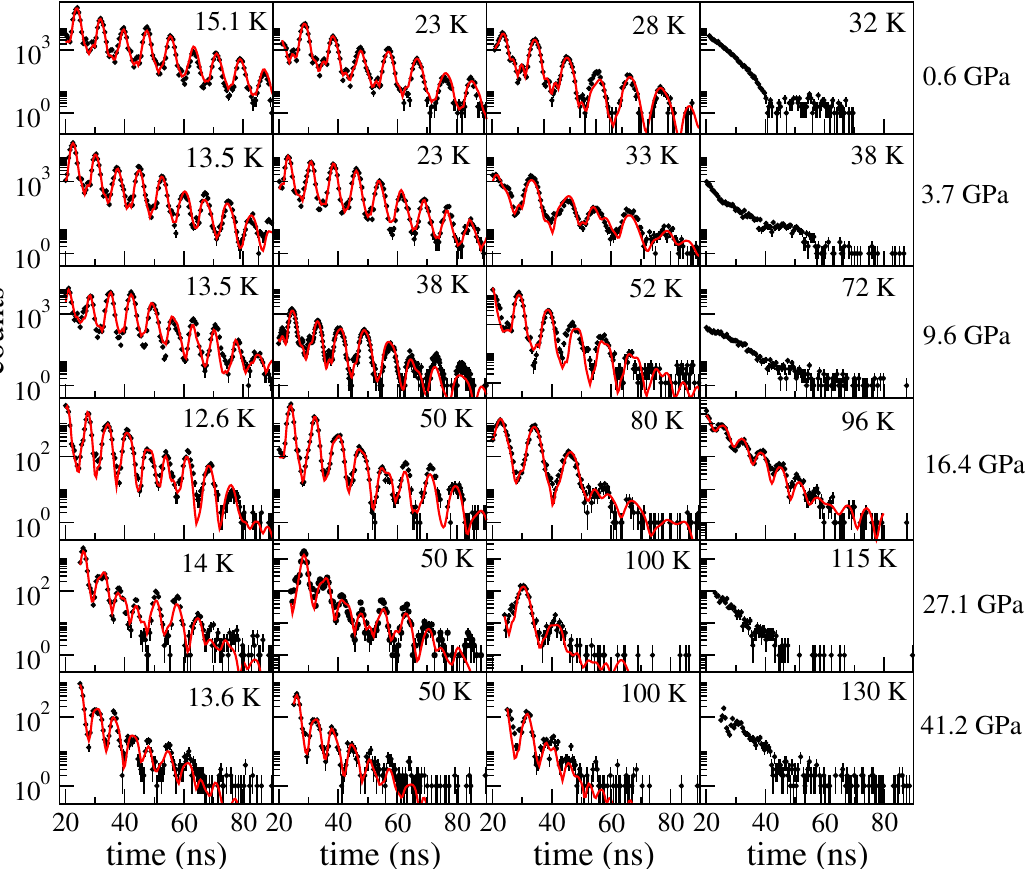
Fig. 3 High-pressure SMS spectra. Selected SMS data of EuSn 2 P 2 at low temperatures and 0.3, 3.7, and 9.6 GPa from run 1, 16.4 GPa from run 2, 21.7 and 41.2 GPa from run 3. The black solid circles are the experimental data and red lines are theoretical simulations in